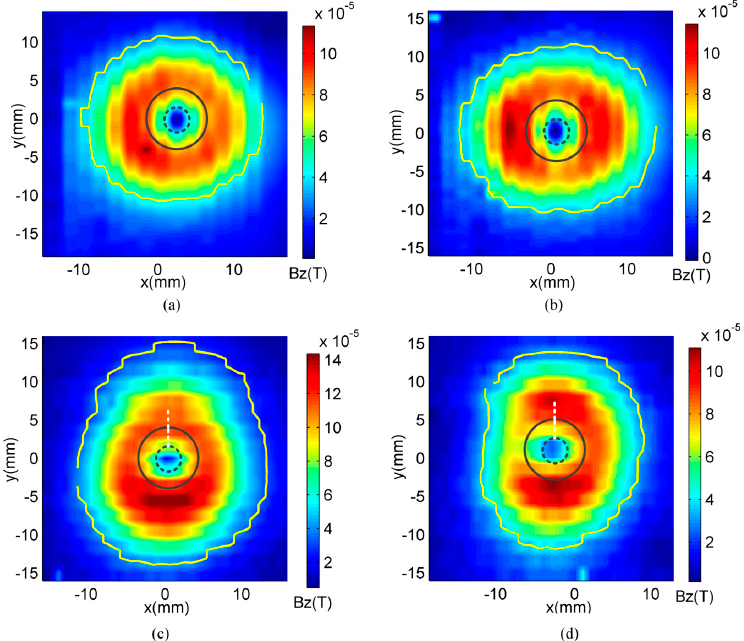
Figure 14. Experiment results of ( a ) defect free rivet generated using optimized coil; ( b ) defect free rivet generated using conventional coil; ( c ) rivet with a 6 mm length 2nd layer defect generated using optimized coil; ( d ) rivet with a 6 mm length defect generated using conventional coil.